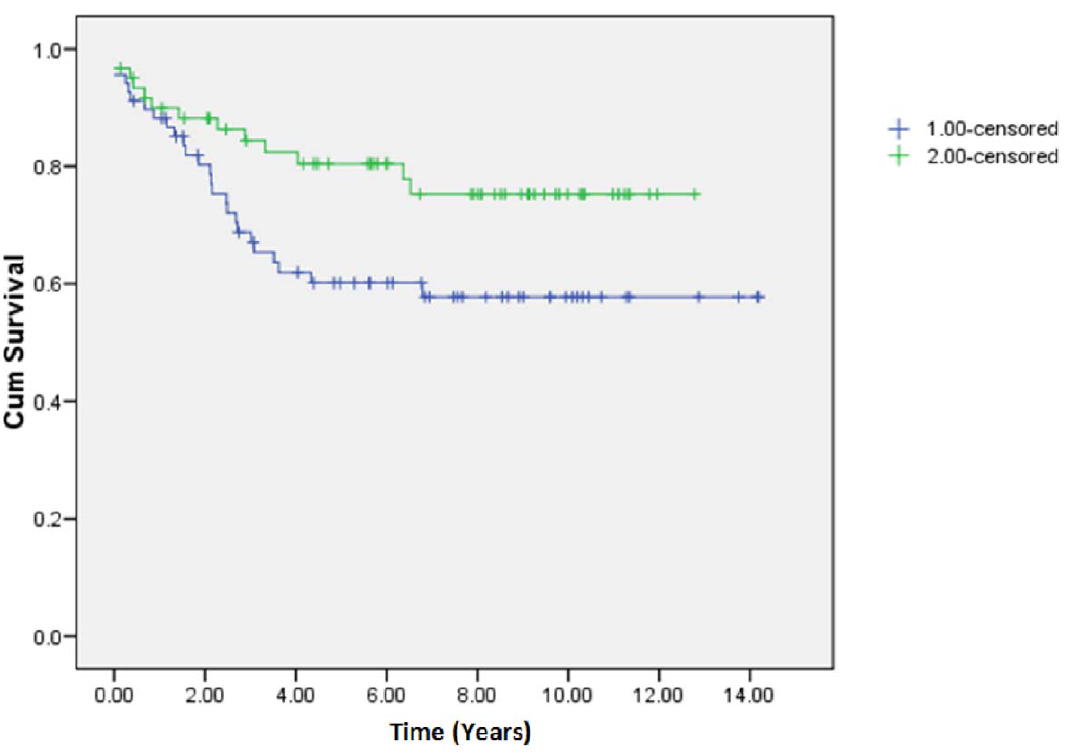
Figure 2. Kaplan-Meier survival curve of the ‘‘CDC25 and CHK1’’ pathway (P-value=0.04). This pathway, which has been highlighted through its highly significant p-value as targeted by genomic alterations, is highly significant in its ability to stratify patients’ prognosis. The figure demonstrates how significant genomic alterations indicate a pathway’s significance as a stratification tool.